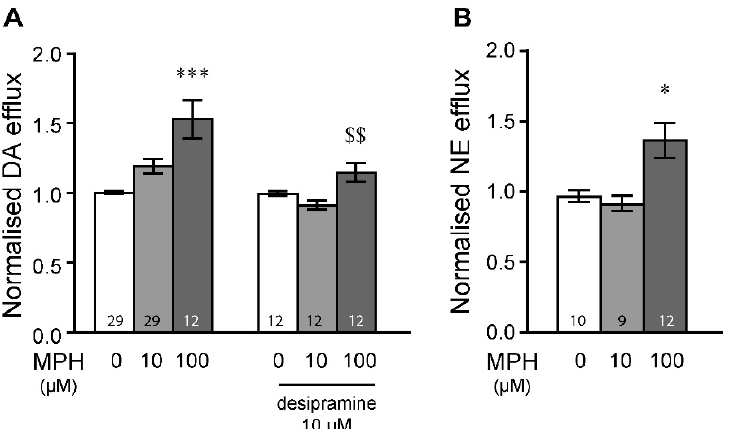
Figure 1. Methylphenidate induce dopamine and norepinephrine efflux in the prefrontal cortex. ( A ) Application of 100 µM of MPH, but not 10 µM, significantly induced dopamine efflux in the PFC, which was efficiently reduced when the norepinephrine transporter inhibitor desipramine (10 µM) was applied as a pre-treatment. ( B ) MPH at 100 µM induced significant norepinephrine efflux in the PFC. * p < 0.05 and *** p < 0.001 vs. respective 0 µM conditions; $$ p < 0.01 vs. 100 µM without desipramine. Bonferroni post hoc tests after significant two-way ANOVAs ( A ) or Tukey’s post hoc tests after significant one-way ANOVAs ( B ). n values are given for each condition and represent number of tissue samples used. DA: dopamine, NE: norepinephrine.